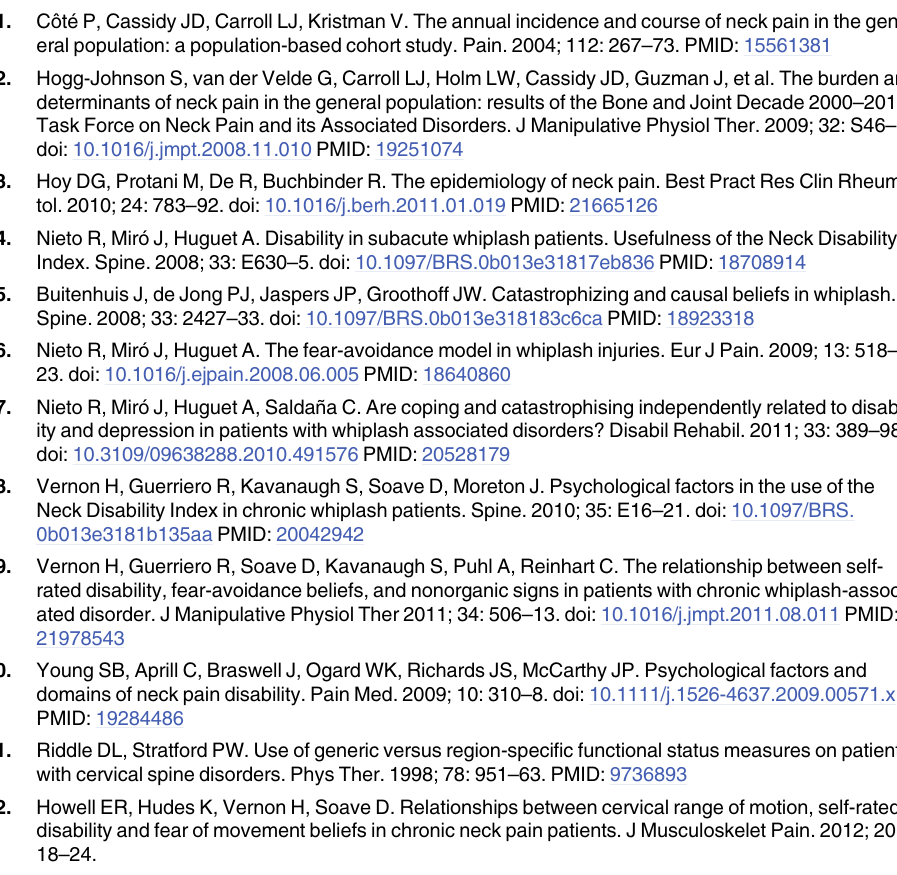
S11 Table. Multiple hierarchical-stepwise regressions for Visual-Analogue Scale (pain) as the dependent variable and family functioning (Self-Estimating Questionnaire) as predic- tors — non-significant results. S12 Table. Multiple hierarchical-stepwise regressions for Visual-Analogue Scale (pain) as the dependent variable and family functioning (Diadic Relationship Scale) as predictors — non-significant results. S13 Table. Multiple hierarchical-stepwise regressions for Visual-Analogue Scale (pain) as the dependent variable and coping styles (CISS) as predictors — non-significant